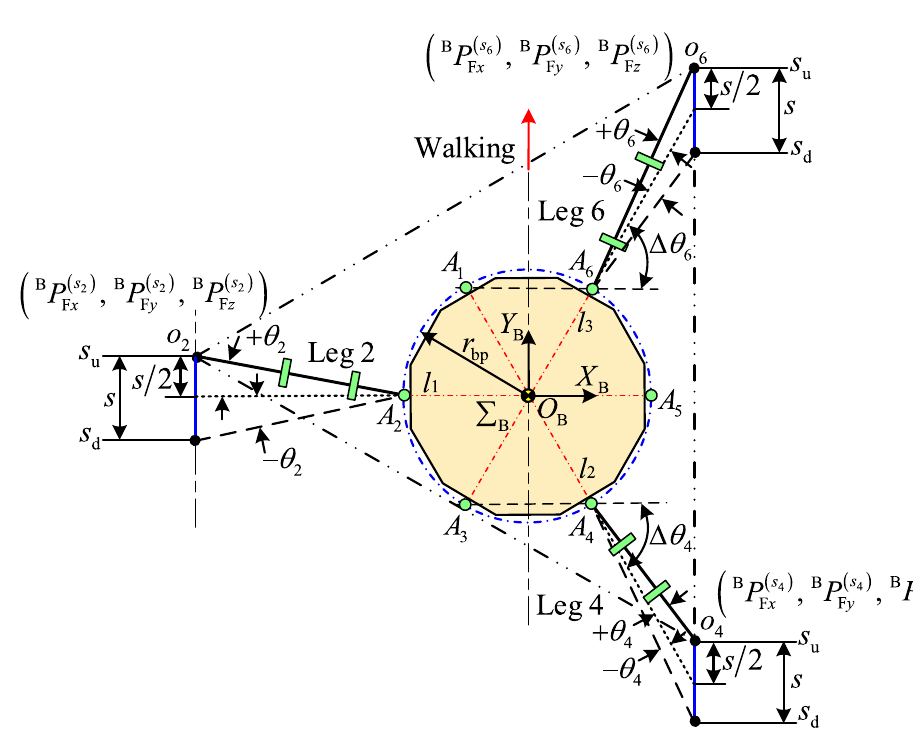
Figure 7 Scheme of support phase under mixture-type II tripod gait